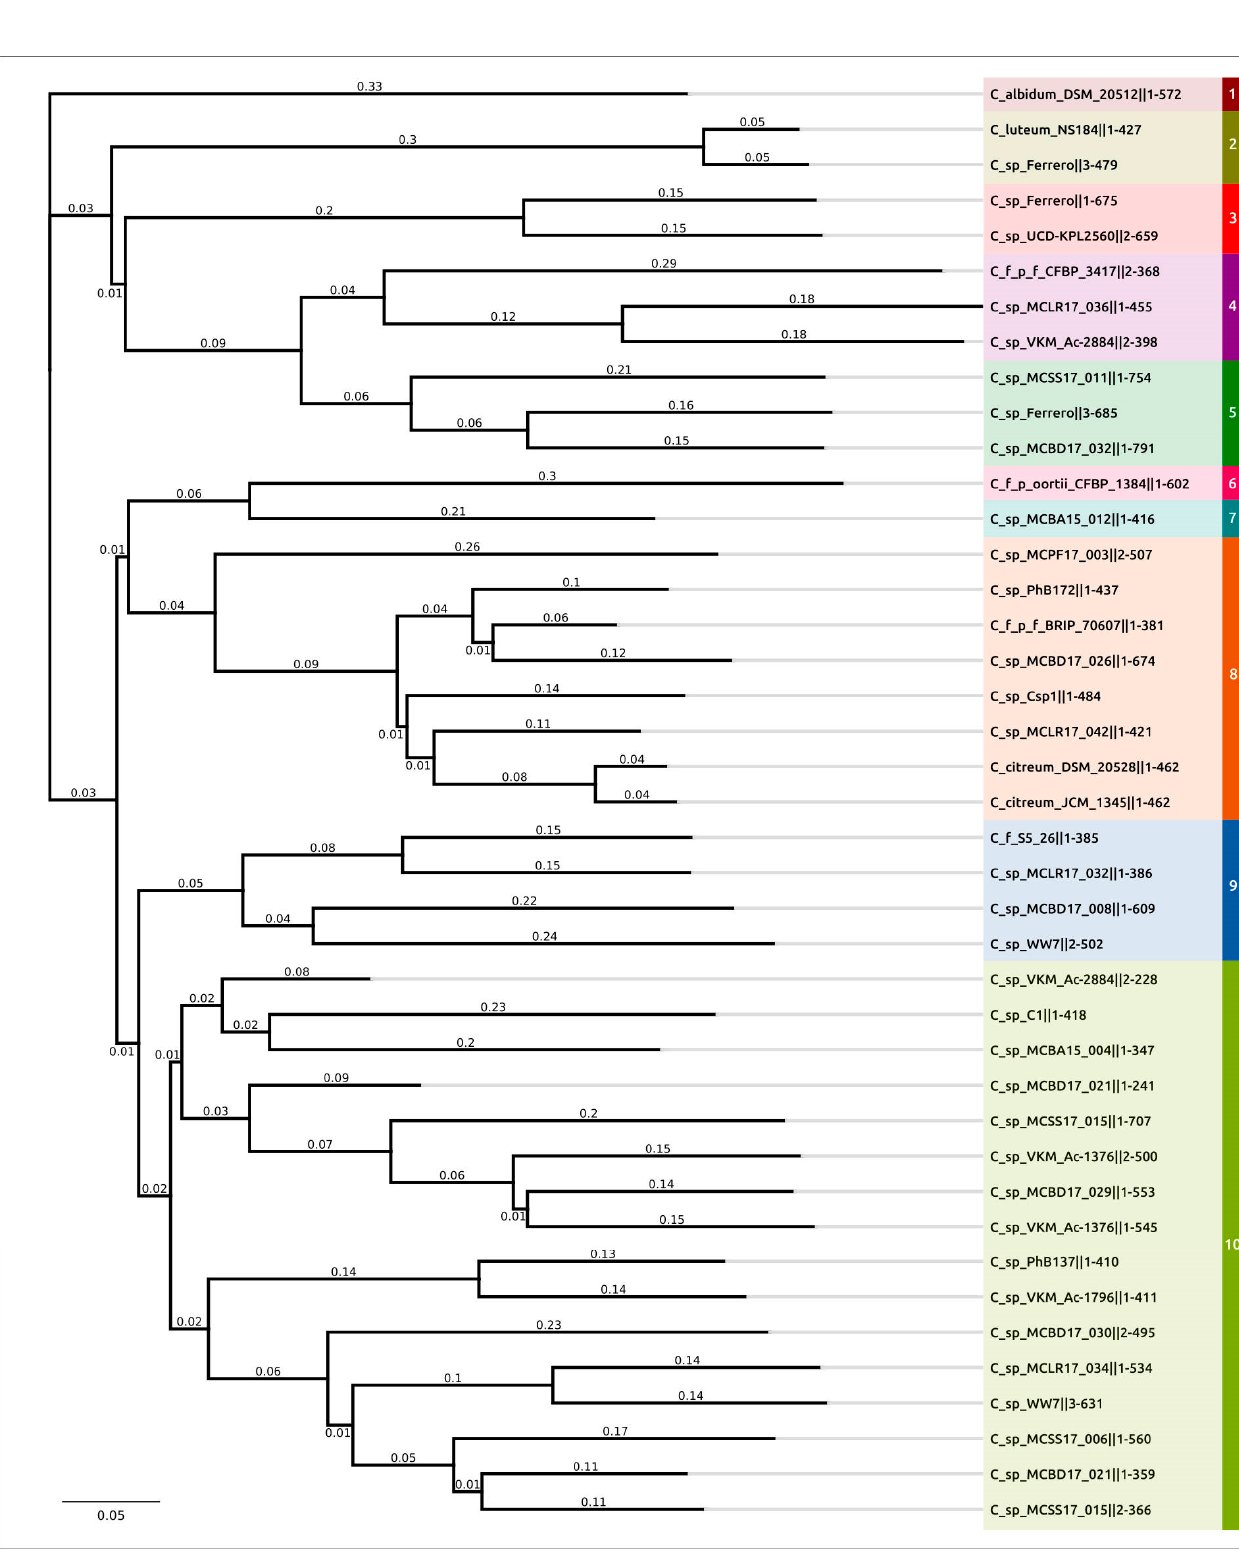
Figure 10. Phylogenetic tree based on amino acid sequences of glycopolymer-degrading enzymes using structural similarity assessed with TM-scores. Branches belonging to different clusters are highlighted using colour. The last three digits in the names of structures indicate the length of protein sequences.